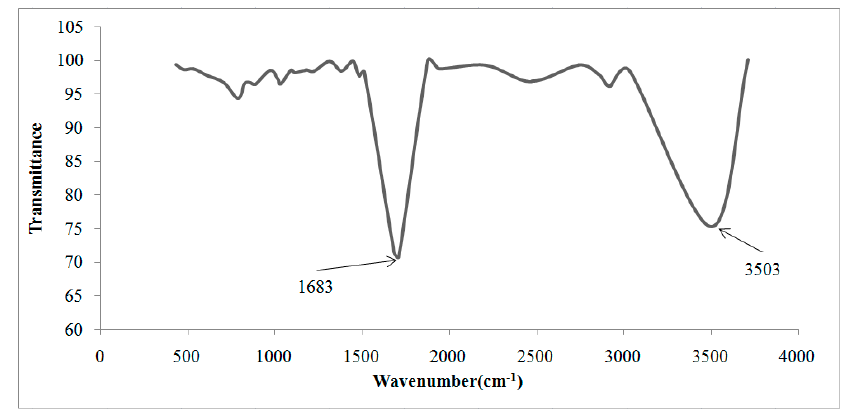
Figure 5. Infrared spectrum from the mixture of resins after Fenton’s treatment.